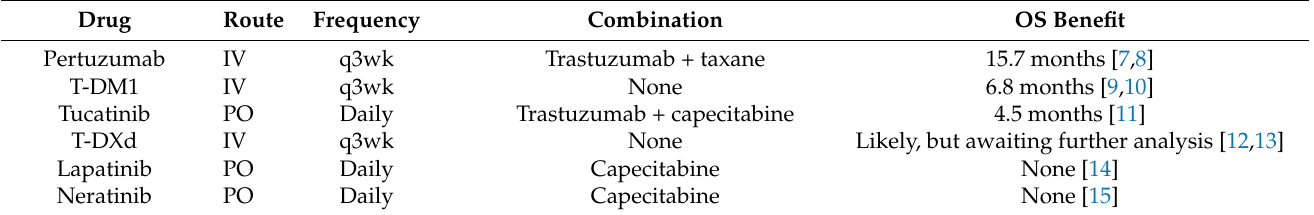
Table 1. Health Canada-approved novel therapies for HER2-positive metastatic breast